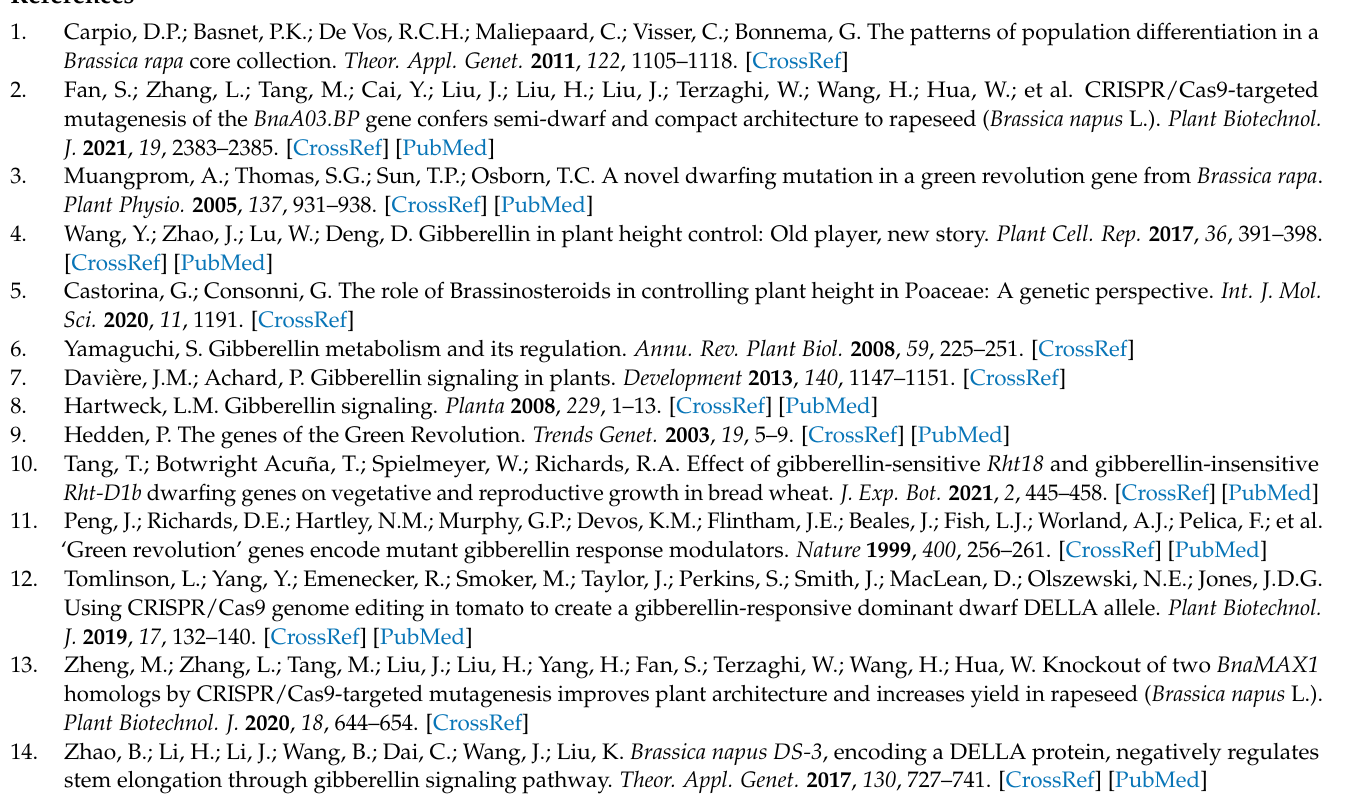
Figure S3: The gene sequence of BraA06g034110.3C ; Table S1: Identified phenotype mean value of YS and Brcd1 YS ; Table S2: Primers sequence; Table S3: Stem and leaf cell number as well as area statistics of YS and Brcd1 YS ; Table S4: Candidate gene